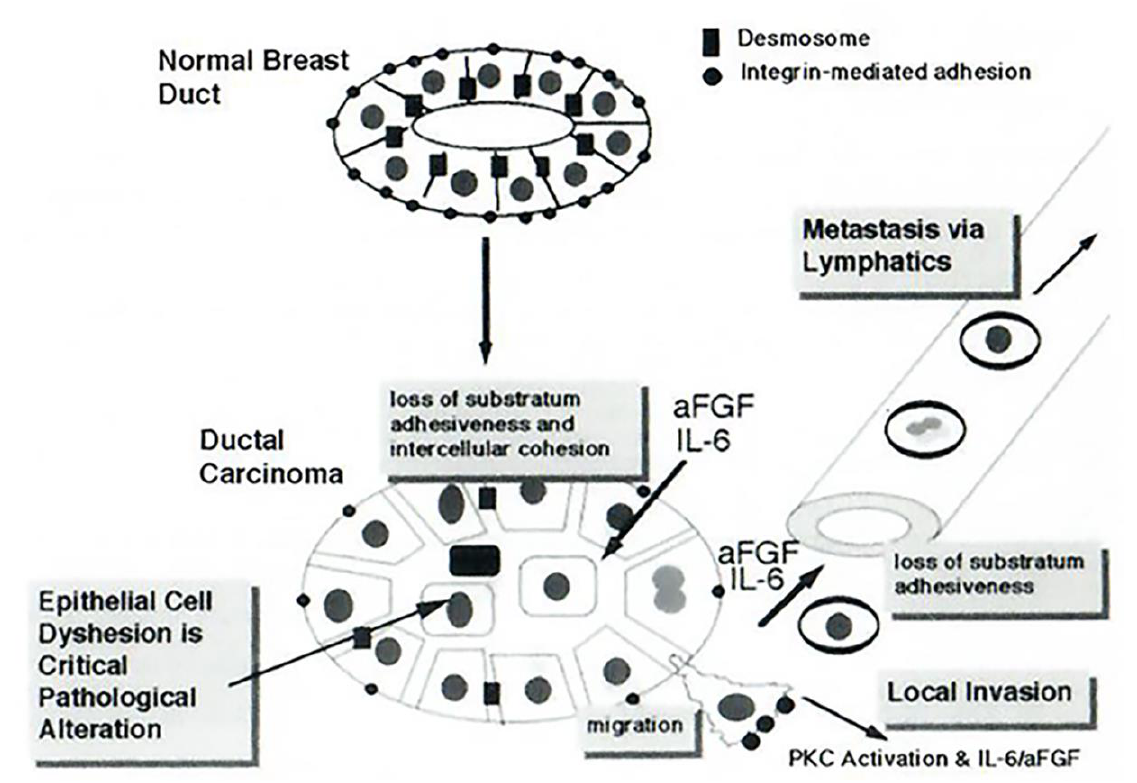
Figure 3. Schematic of cytokine-induced effects on invasiveness and metastasis of breast carcinoma cells. Reprinted with permission from ref. [4]. 1998, Birkhauser Verlag.